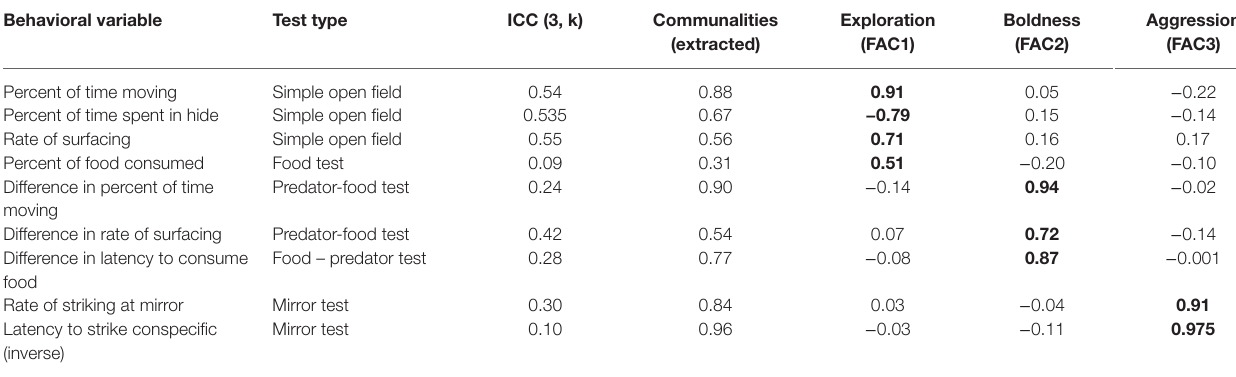
The table shows the rotated factor matrix. Bold scores indicate the component on which the factor